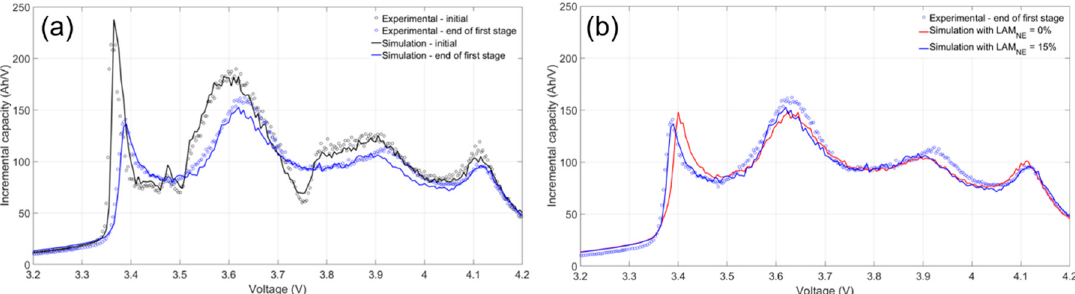
Figure 7. ( a ) Representative fits for the experimental IC curves at the start and end of the initial stage of aging. ( b ) Fits for the experimental IC curves at the end of the initial stage of aging with and without considering the loss of active material at the negative electrode (LAM NE ).